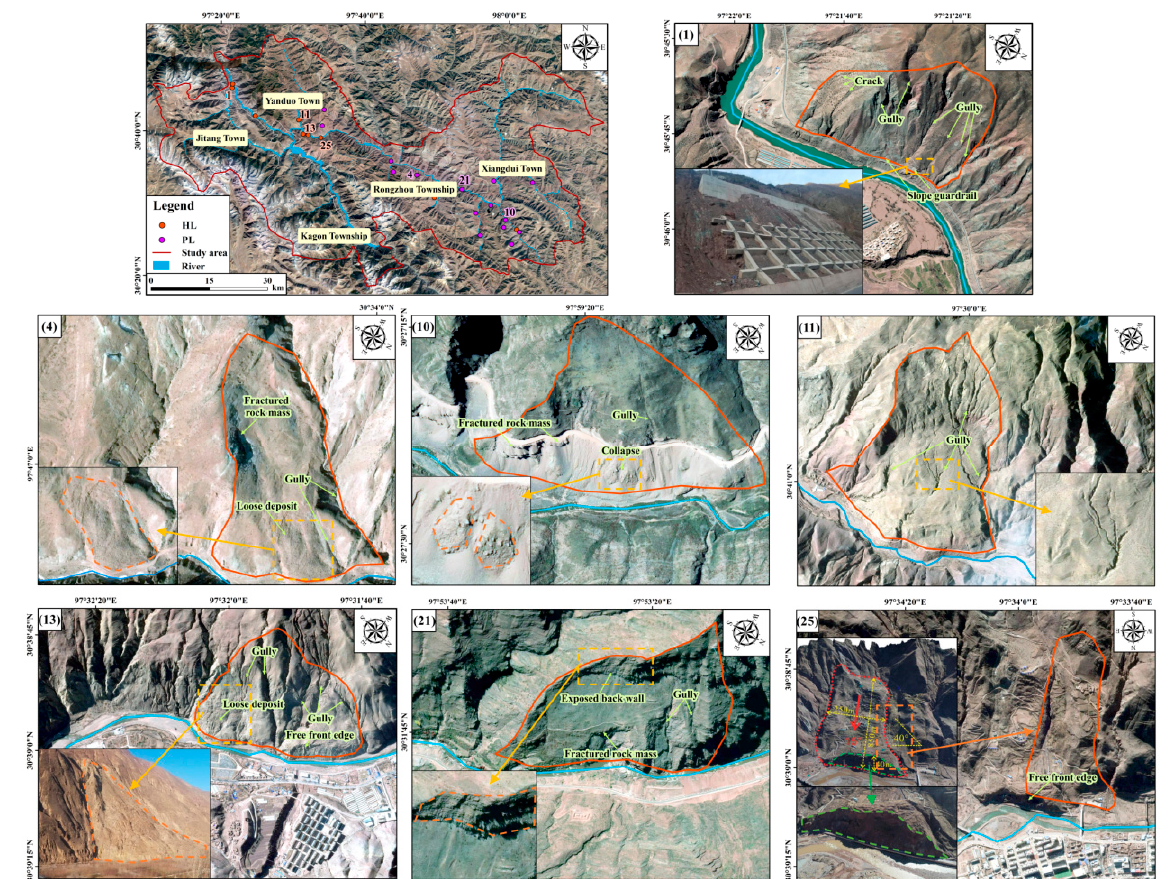
Figure 6. Validation of identified active landslides via field survey, UAV images, and 3D mapbox images. The field survey photos and UAV images are provided by Bureau of Geology and Mineral Exploration and Development of Tibet Autonomous Region and from the reference [62].